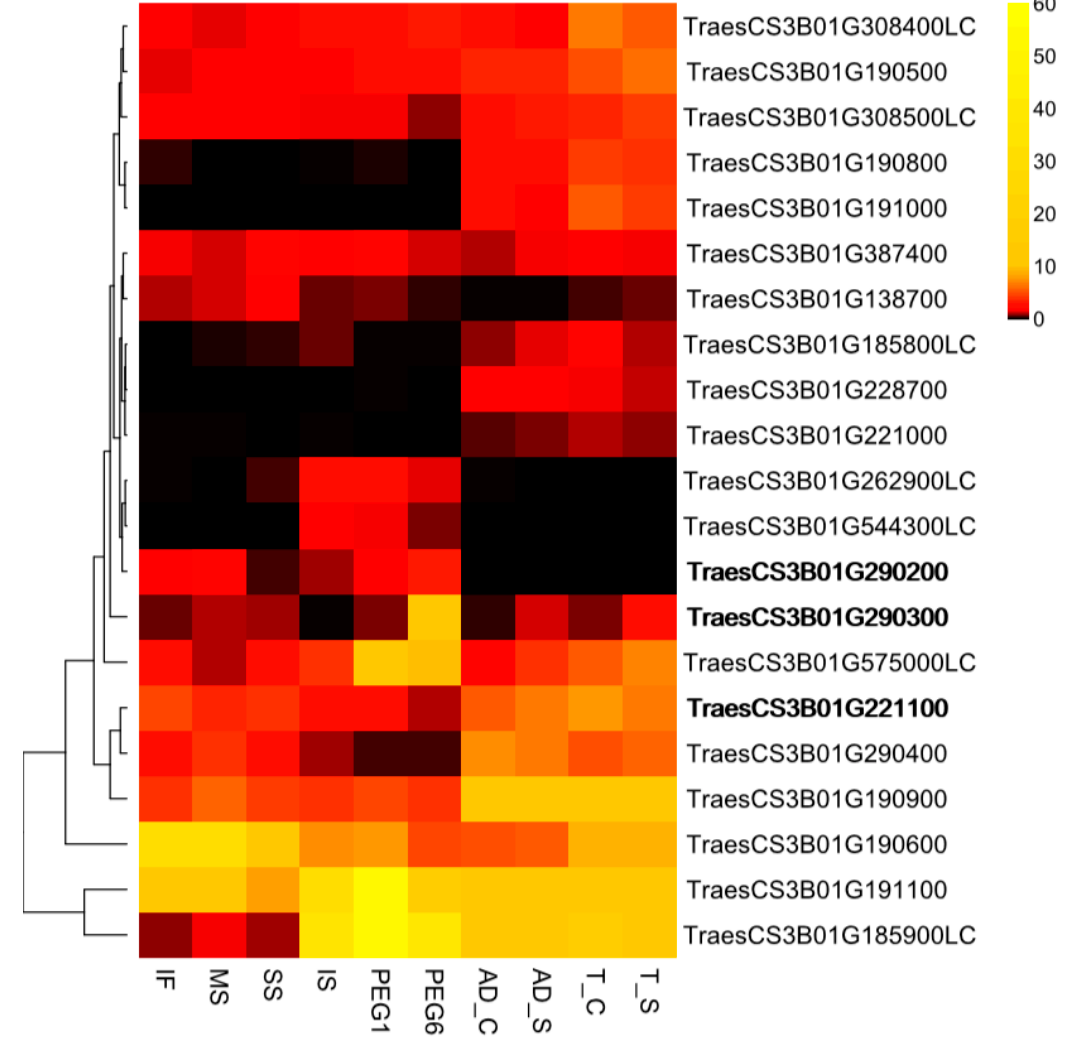
Figure 6. Gene expression analysis under di ff erent stress conditions for candidate genes located within a +/ − 300 kb window and in proximity to wheat chromosome 3B ISBP markers. Di ff erentially expressed genes (DEGs) are shown in bold. IF: irrigated field conditions; MS: mild stress field conditions; SS: severe stress field conditions [27]; IS: seedling PEG shock control; PEG1: seedling 1 h PEG stress; PEG6: seedling 6 h PEG stress [22]; AD_C: anther stage irrigated shelter phenotype; AD_S: anther stage drought stressed shelter phenotype; T_C: tetrad stage irrigated shelter phenotype; and T_S: tetrad stage drought shelter phenotype [26].